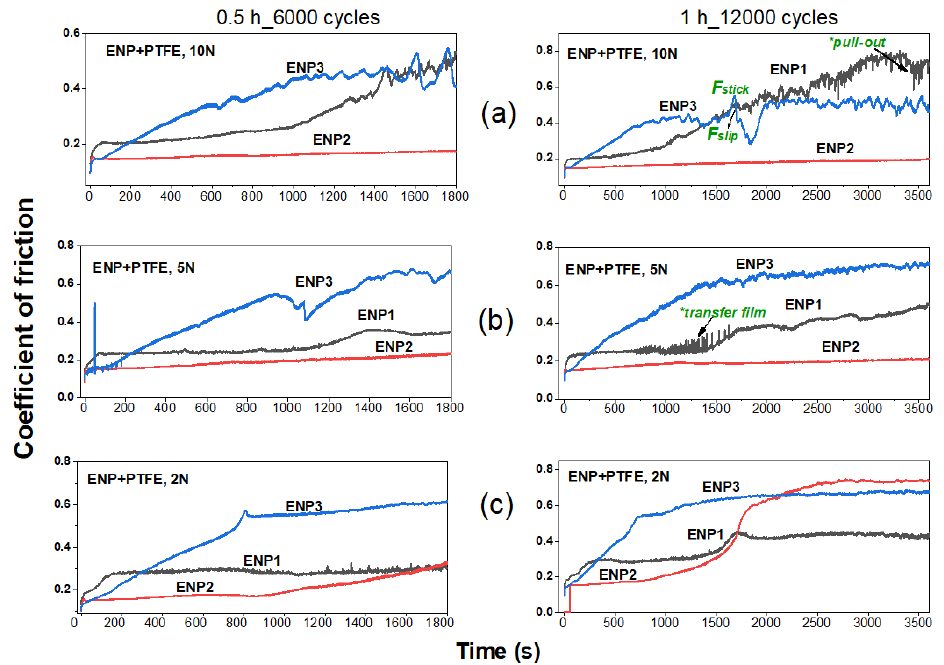
Figure 6. The evolution of coefficient of friction as a function of time at various loads and sliding cycles of the ENP+PTFE: ENP1, ENP2 and ENP3 duplex coatings.